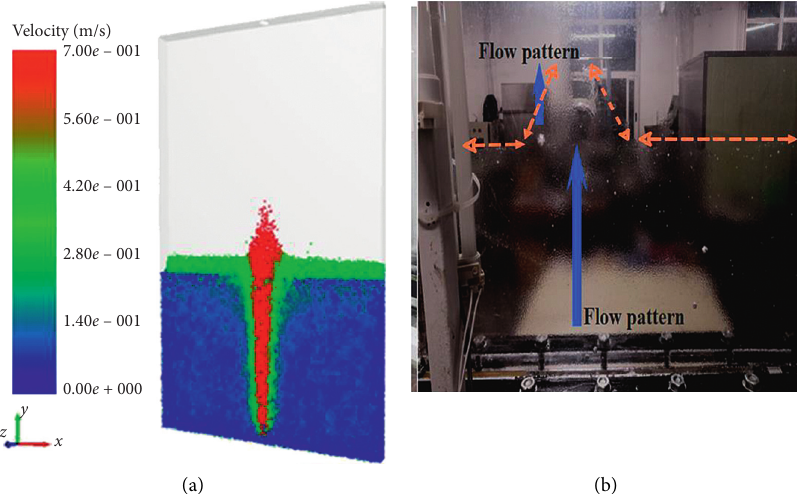
Figure 5: Image illustration of the fluidized cavity regime: (a) numerical observation; (b) experimental observation.